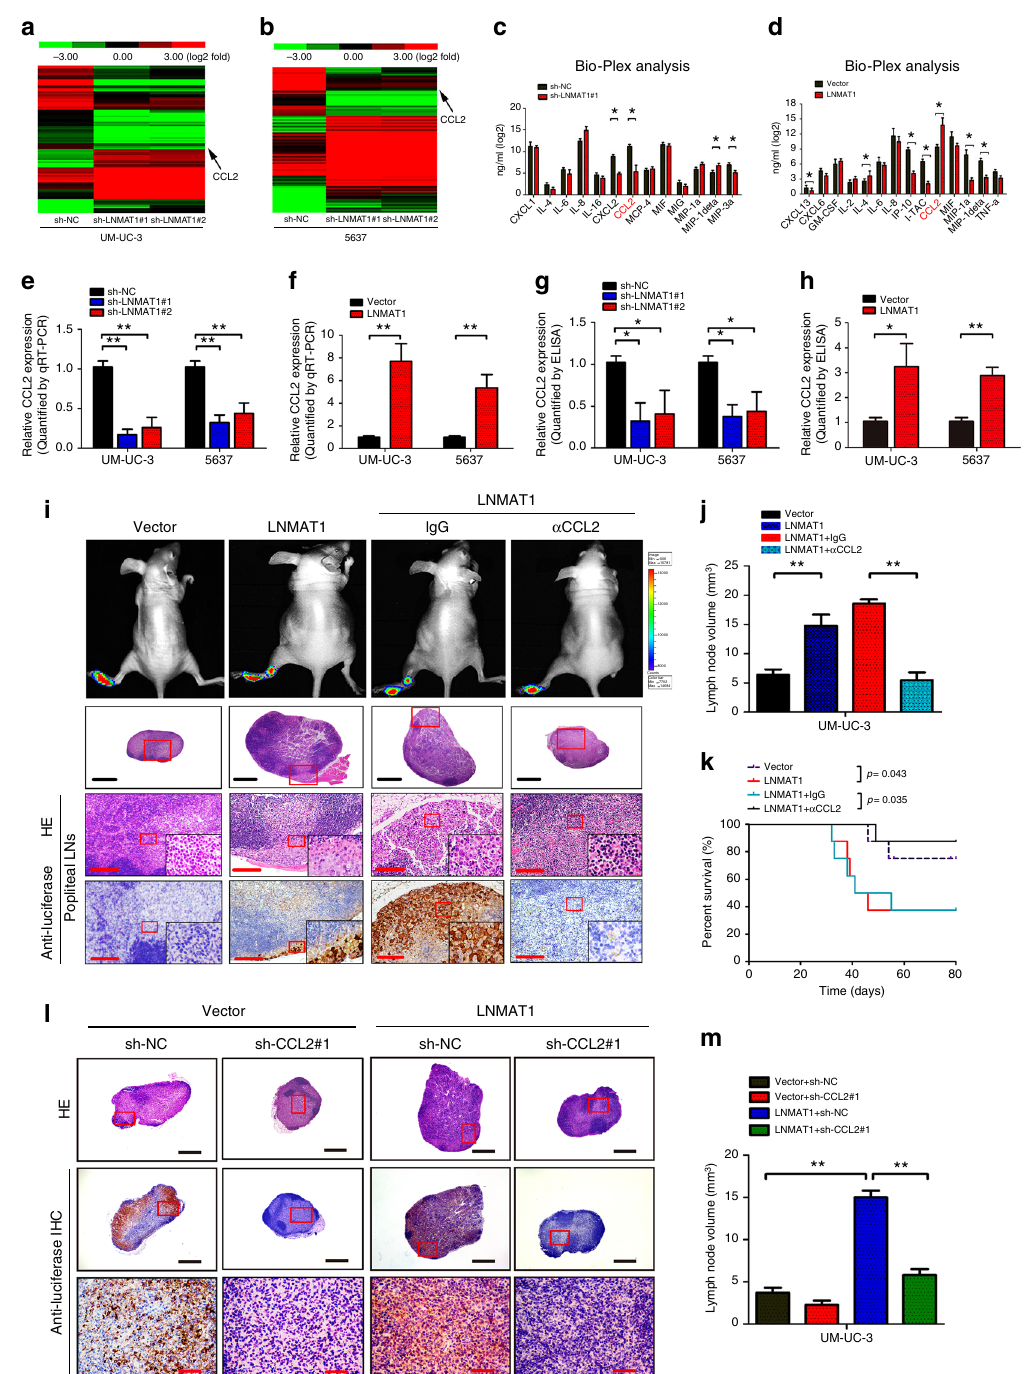
Fig. 4 CCL2 is required for LNMAT1 -induced LN metastasis. a , b Heatmap representing unsupervised hierarchical clustering of genes regulated by LNMAT1 based on next-generation sequencing (NGS) analysis. Rows represent probe sets, and columns represent samples treated as indicated. Green, downregulation; red, upregulation. CCL2 is indicated by black arrows. c , d Bio-Plex multiplex immunoassay analysis of protein expression of 40 cytokines and chemokines regulated by LNMAT1 . Two-tailed t -tests was used. e , f qRT-PCR of CCL2 expression in LNMAT1 -transduced, LNMAT1 -silenced and control cell as indicated. Statistical signi fi cance was assessed using one-way ANOVA followed by Dunnett ’ s tests for multiple comparison and two-tailed t -tests. g , h ELISA of CCL2 expression in the indicated cells. Statistical signi fi cance was assessed using one-way ANOVA followed by Dunnett ’ s tests for multiple comparison and two-tailed t -tests. i Representative images of popliteal LNs, enucleated LNs and IHC staining with anti-luciferase antibody in the indicated mice group ( n = 16 per group). Scale bars: black, 500 µ m; red, 50 µ m. j , k The ratios of the metastatic to volume quanti fi cation ( j ) and Kaplan – Meier survival analysis ( k ) for the indicated group ( n = 16 per group). Two-tailed t -tests was used. l Representative images of HE and IHC staining con fi rming the LN status ( n = 16). Scale bars: black, 500 µ m; red, 100 µ m. m Volume quanti fi cation of popliteal LN metastasis after shRNA-mediated depletion of CCL2. One-way ANOVA followed by Dunnett ’ s tests for multiple comparison was used. The error bars represent standard deviations of three independent experiments. * p < 0.05 and ** p <